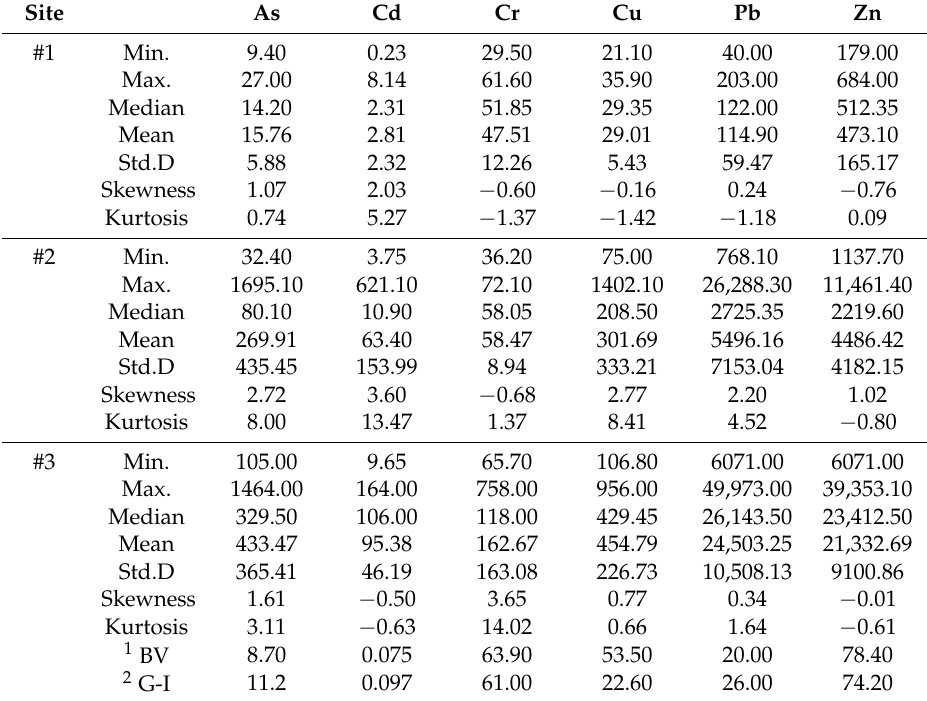
Table 4. Descriptive statistics of PTE concentrations (mg/kg) in top soils of the three abandoned sites. Site